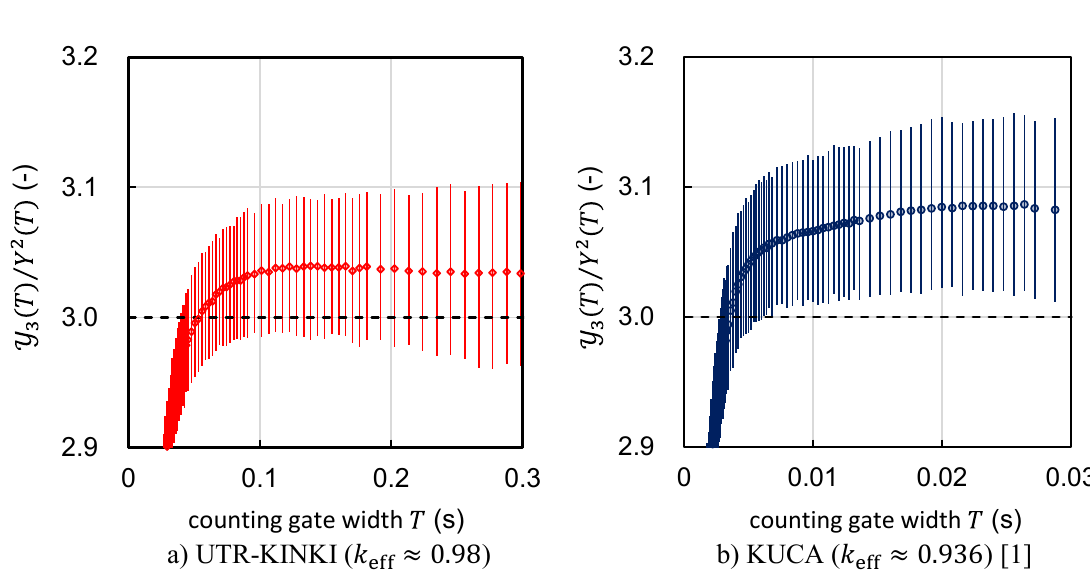
𝟐 (𝑻) (𝒀(𝑻)) ⁄ in subcritical systems driven by 𝟑